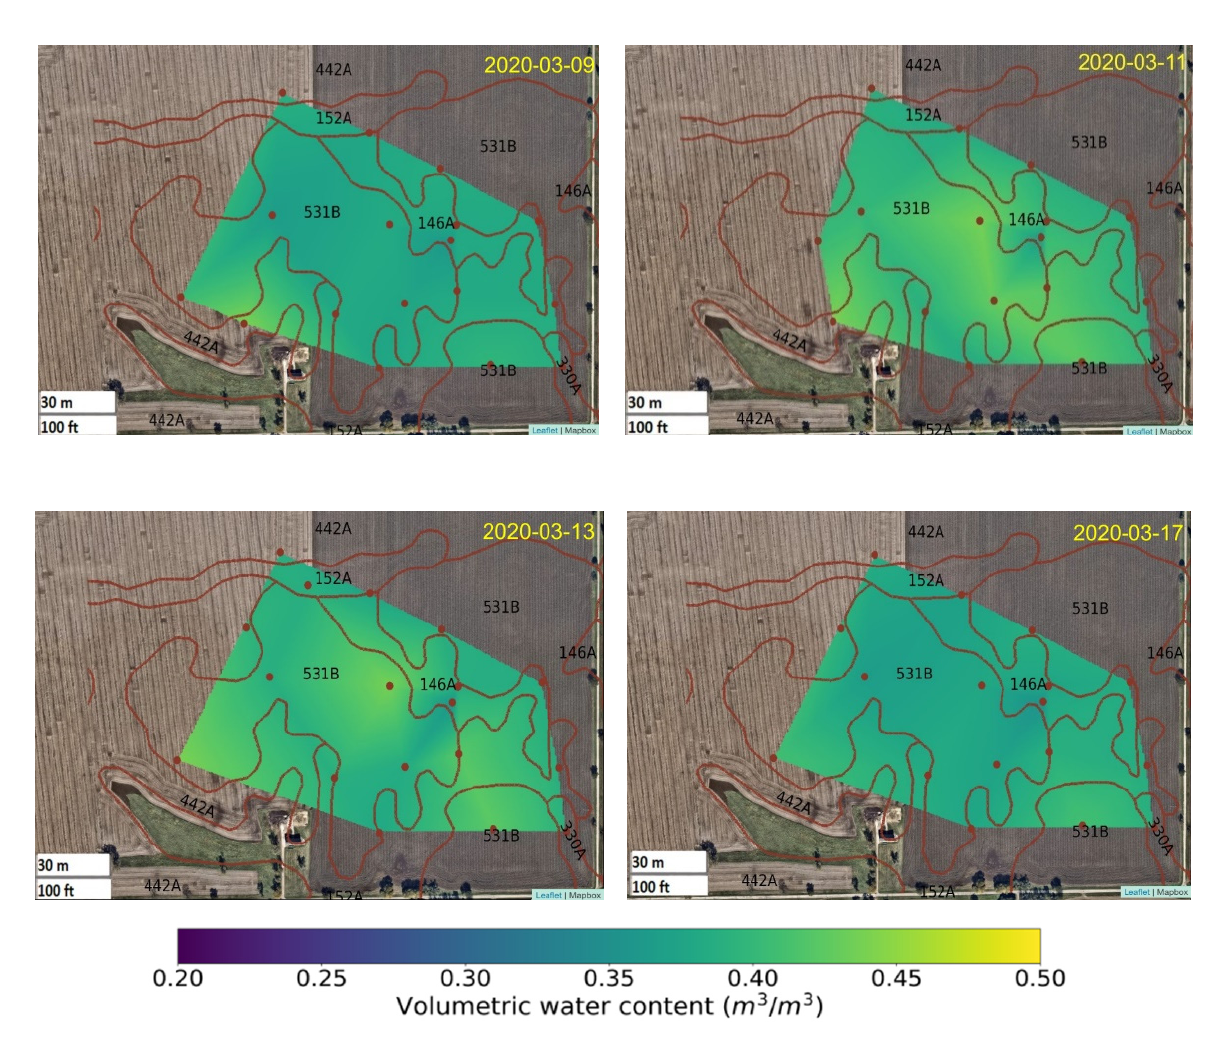
Figure 5. Volumetric water content (m 3 /m 3 ) daily average intensity maps before and after 24.6 mm precipitation. Brown dots indicate sensor location and brown lines/numbers indicate soil types (brown lines and numbers denote USDA soil type assessment). Intensity maps were generated by linear interpolation between measured points.